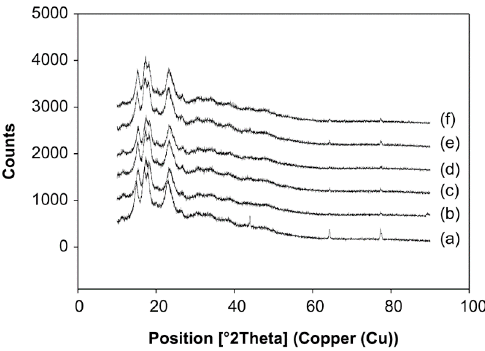
Figure 15. X-ray diffraction pattern of native and modified sago starch. ( a ) Native starch. ( b ) Modified starch with ozone-oxidized treatment at pH 4 and the starch concentration of 10%. ( c ) Modified starch at pH 4 and 20% starch. ( d ) Modified starch at pH 4 and 30% starch. ( e ) Modified starch at pH 7 and 20% starch. ( f ) Modified starch at pH 10% and 20% starch.